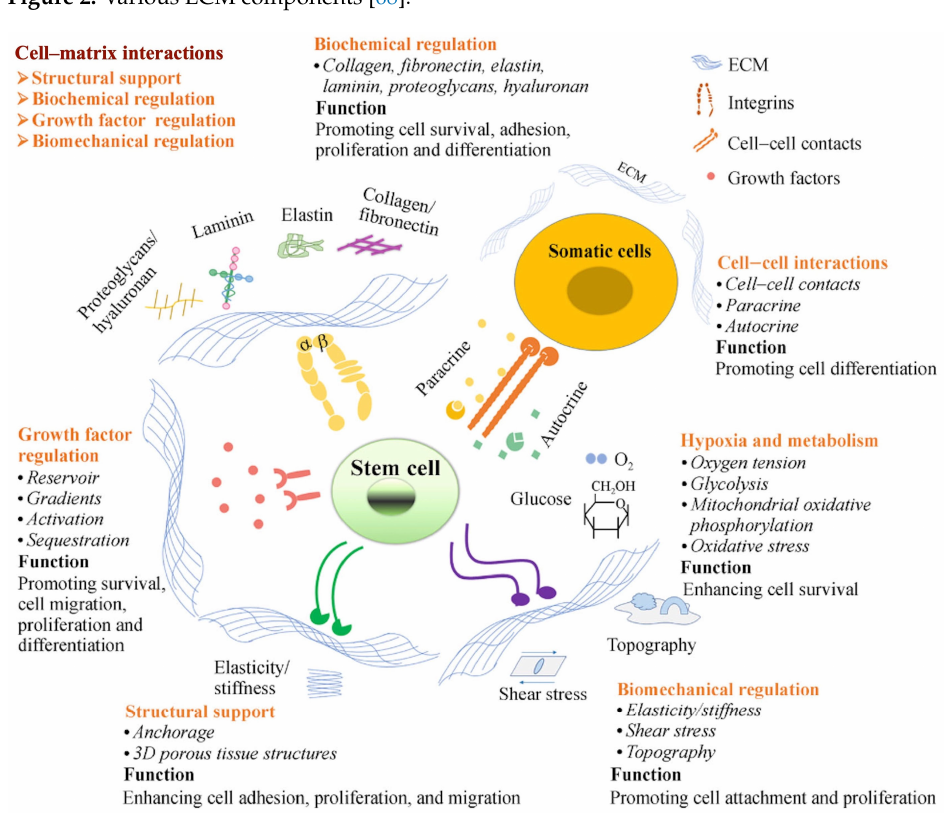
Figure 3. The role of the ECM acting as the cellular niche of stem cells [77]